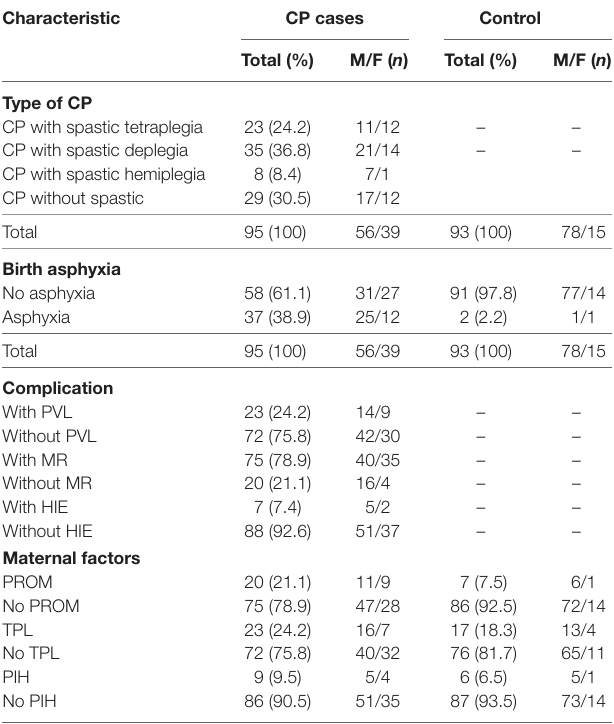
TaBle 2 | Sample description for cytokine production